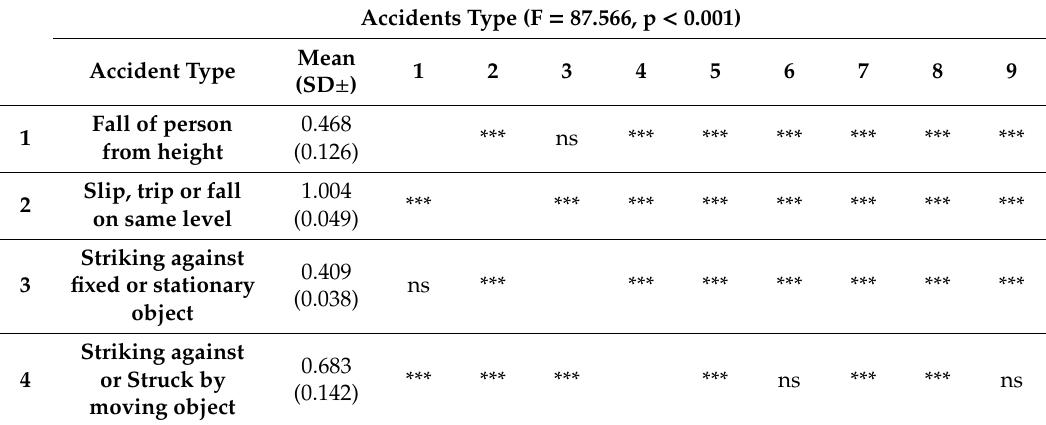
Table 4. One-way analysis of variance (ANOVA) results based on incidence rates (IRs).